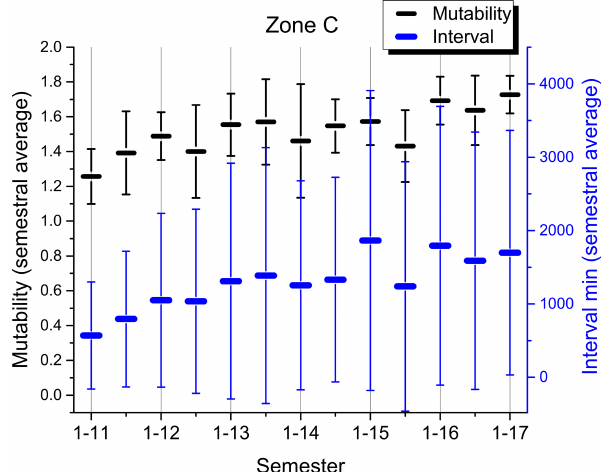
Figure 11. Semestral average of mutability values (upper symbols; black) and intervals in minutes between consecutive seisms (lower symbols; blue) for zone C (calm). Odd semesters are labeled on the abscissa axis (1–13; first semester of 2013), while even semesters are only marked.